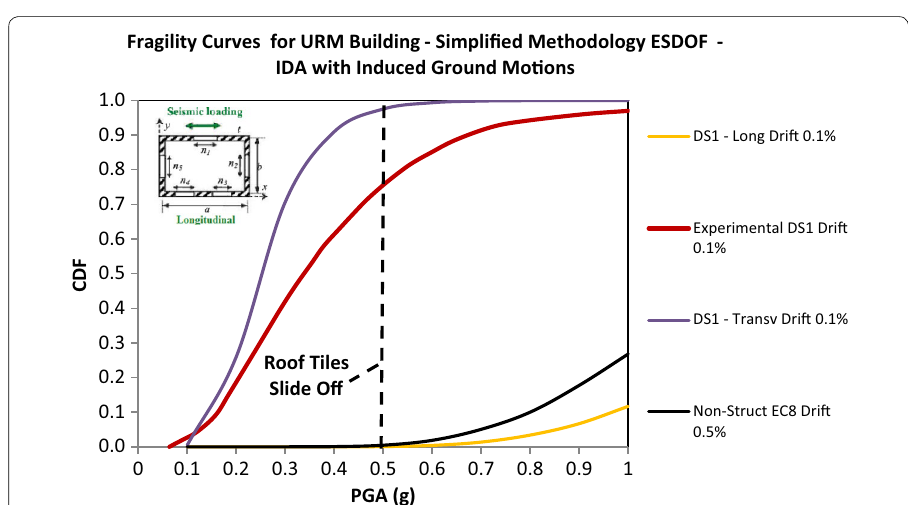
Fig. 10 Analytical fragility curves for first damage state (pre-yielding damage state—DS1) for an unreinforced masonry building (URM) tested experimentally on a shake table. Longitudinal (Long) and transversal (Transv) or short plan view directions of shaking are considered. The Eurocode 8 (EC8) drift limit for brittle non-structural components is also applied. The vertical dashed line dictates the experimental PGA threshold over which detachment of the roof tiles of the URM building under study has been